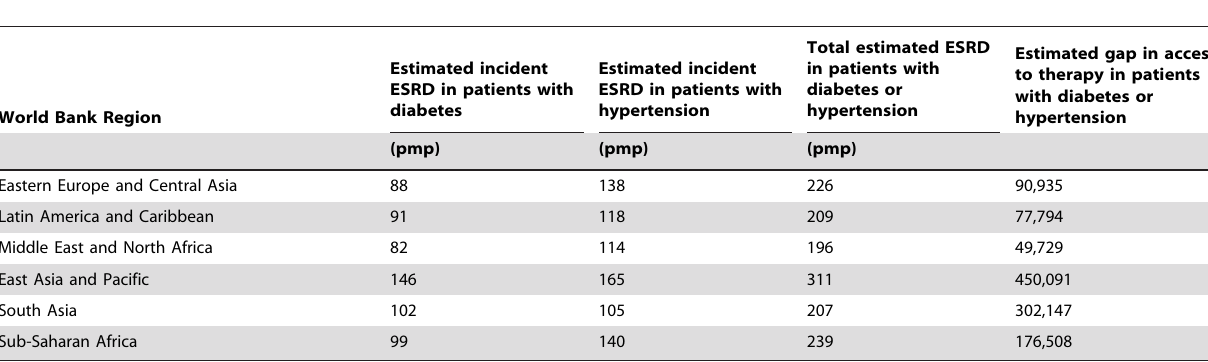
Table 2. Estimated incident ESRD and reported initiation of RRT in patients with diabetes and hypertension.